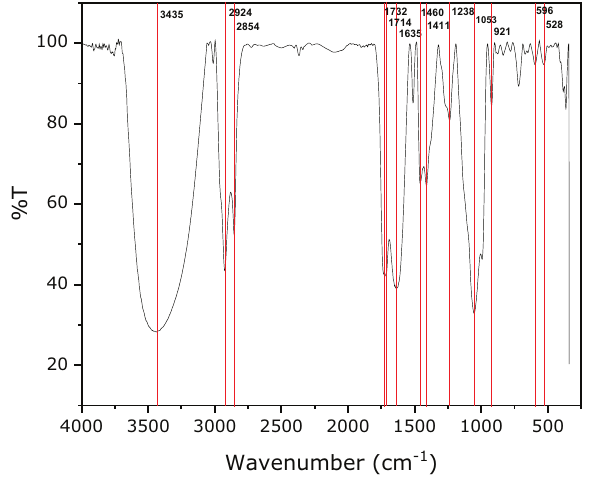
Figure 4. FTIR spectrum of methanol extract of M. oleifera leaves.